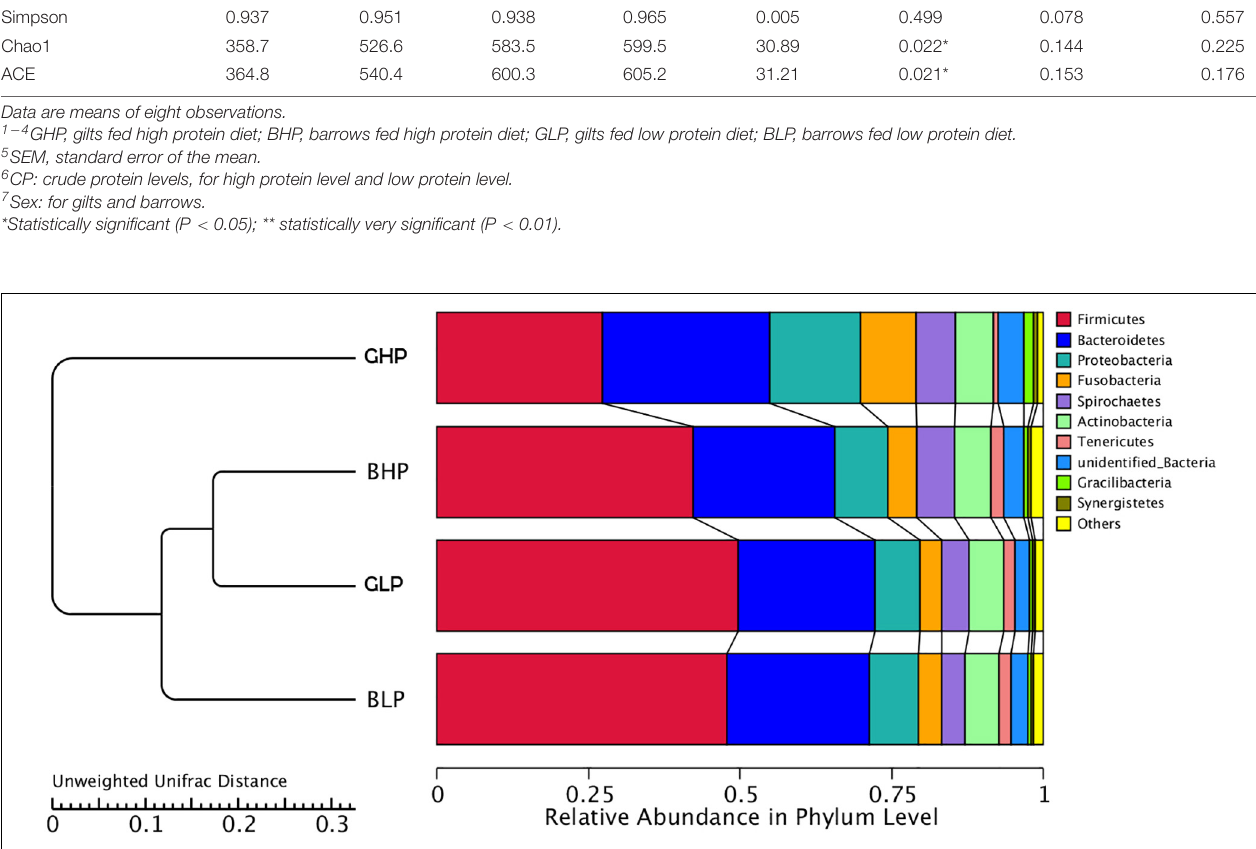
FIGURE 2 | UPGMA cluster tree based on weighted unifrac distances of the OTU community. GHP, gilts fed high protein diet; BHP, barrows fed high protein diet; GLP, gilts fed low protein diet; BLP, barrows fed low protein diet. and unidentified Prevotellaceae ( P = 0.00). In addition, the abundances of Gracilibacteria ( P < 0.05) and unidentified bacteria ( P = 0.00) were significantly affected by dietary protein levels, and showed significant interactions ( P < 0.05) between dietary protein levels and pig sex.